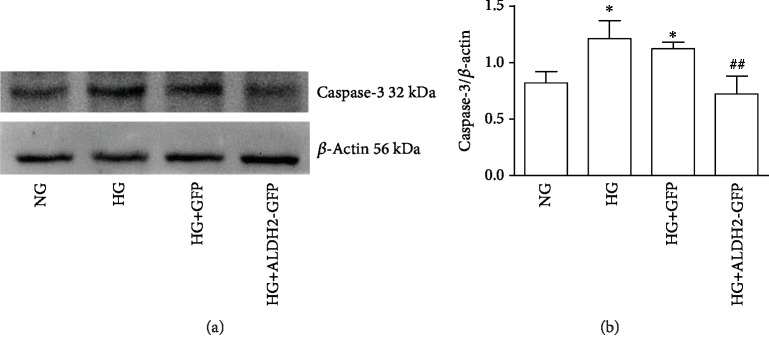
Changes of Caspase-3 protein level in each group. (a) Representative blots of Caspase-3 in H9C2 cardiac cells. (b) Caspase-3 normalized by β-actin level protein levels in H9C2 cardiac cells (mean ± SD, n = 4). ∗P < 0.05vs. NG; ##P < 0.01vs. HG and HG+GFP.